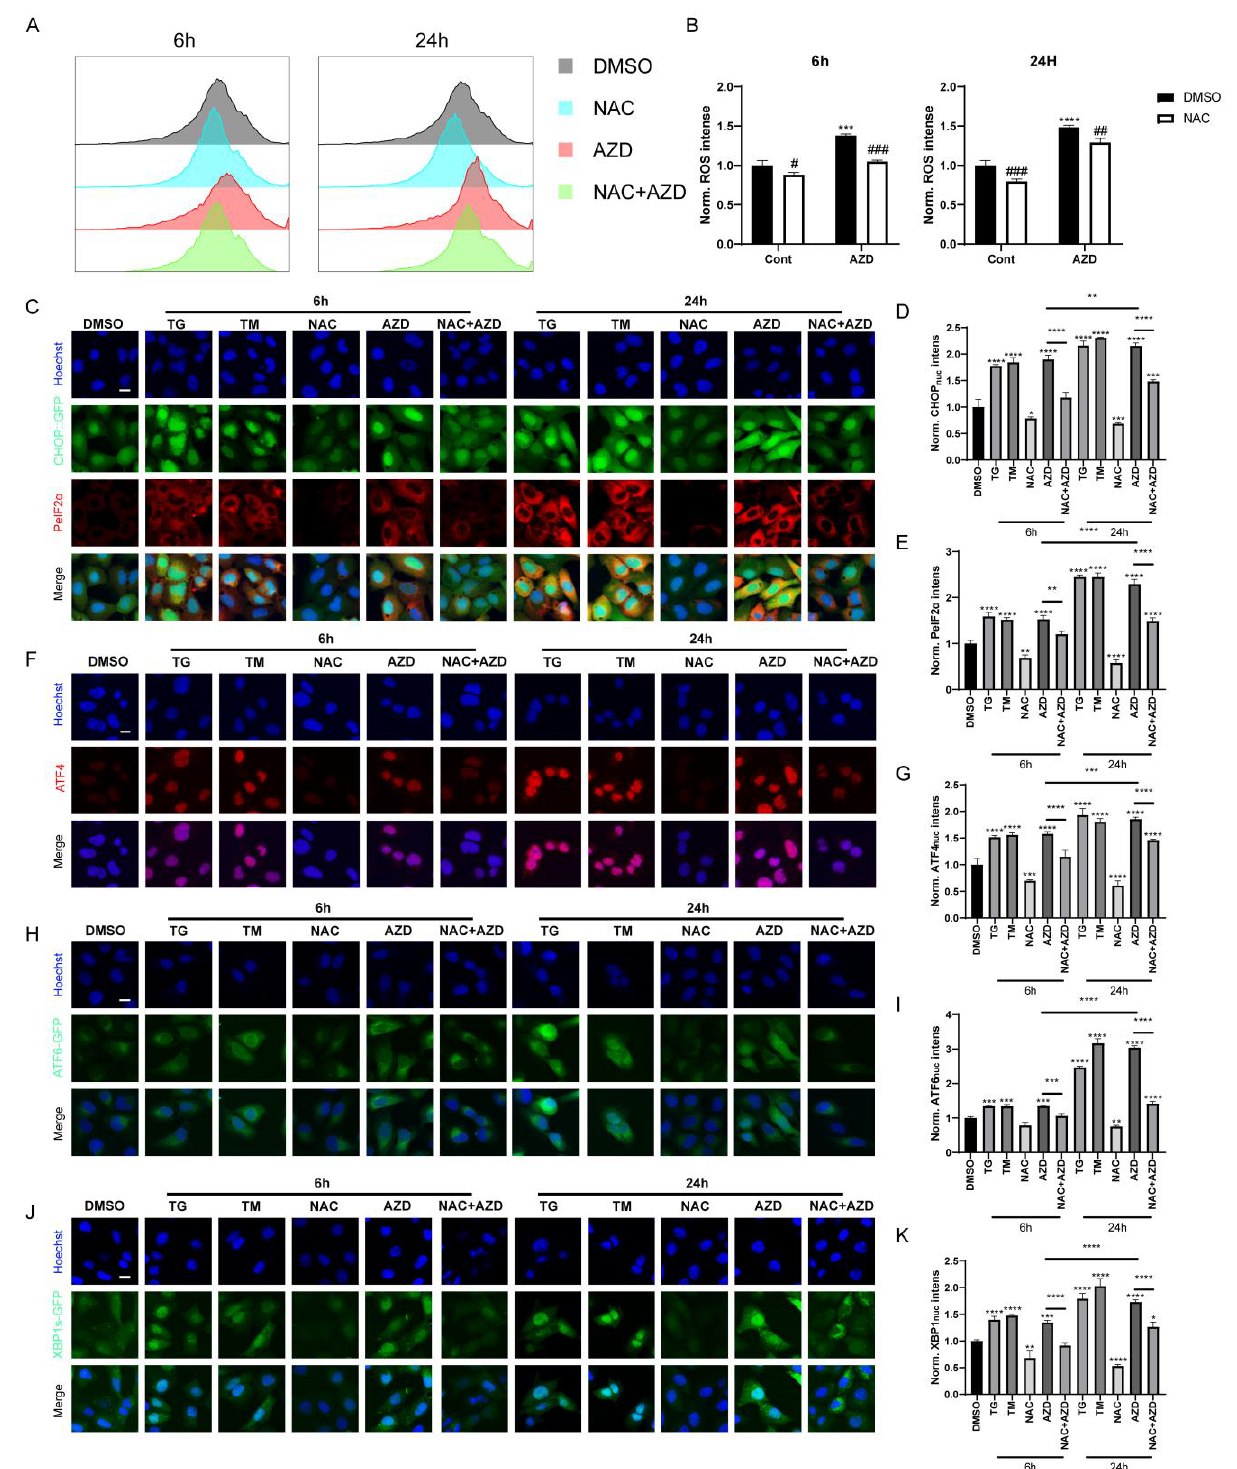
FIGURE 4: AZD induces ROS accumulation and ER stress. (A, B) ROS generation was detected by DCFH-DA probe. MCA205 cells were treated with AZD (40 µM) combined or not with NAC (3 mM) for 6 h or 24 h. Fluorescence intensity histogram (A) and average fluorescence intensity (B) are presented. (C-E) CHOP::GFP-expression U2OS cells were treated with TM (3 μM) , TG (3 μM) , AZD, NAC or NAC combined AZD for 6 h or 24 h, and PeIF2α was assessed by immunostaining. Representative images are presented (C) . The intensity of fluorescence was measured (D, E) ; (F-K) wild type, ATF6-GFP-expression and XBP1s- ΔDBD -venus-expression U2OS cells were treated with TM, TG, AZD, NAC or NAC combined AZD for 6 h or 24 h , then ATF4 was assessed by immunostaining, ATF6 and XBP1s was assessed by GFP intensities. Representative images of ATF4 (F) , ATF6 (H) and XBP1s (J) nuclear translocation are presented. The average nuclear intensity of ATF4 (G) , ATF6 (I) and XBP1s (K) was assessed. Scale bars equal 10 μm. *P<0.05; **P < 0.01; ***P < 0.001; **** P < 0.0001 compared with DMSO. And the horizontal line indicates the comparison between the two